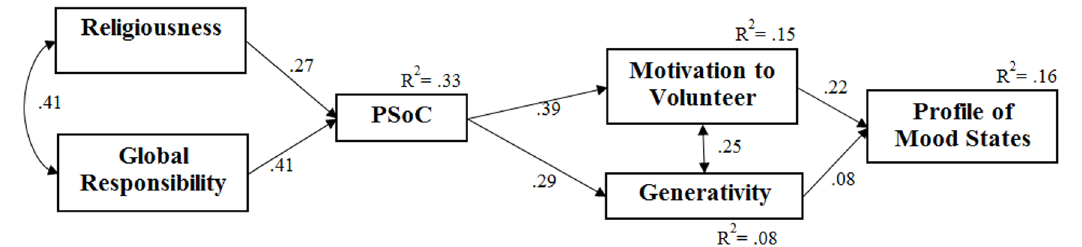
Figure 2. Results of path